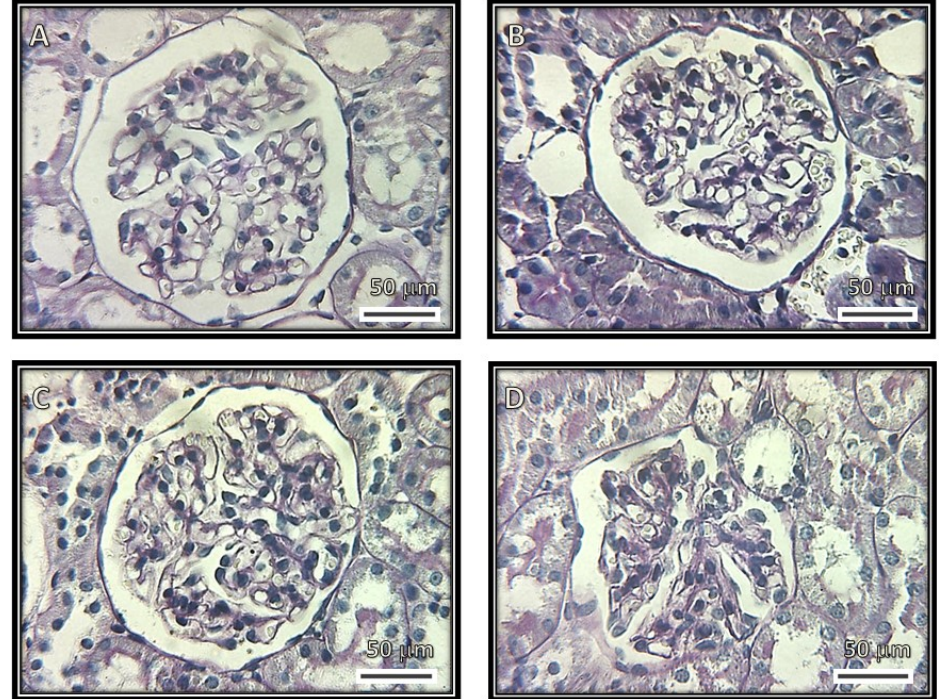
Figure 1. Representative photomicrographs of rat renal cortexes. The images show glomeruli from ( A ) control, ( B ) kidneys from rats injected with saline solution and ( C ) kidneys from rats injected with serum from healthy subjects. Open capillary loops, basement membranes and Bowman’s capsules positive for periodic acid–Schi ff stain (PAS) staining can be observed in these panels. ( D ) Kidneys from rats that were injected with serum from patients with collapsing glomerulopathy. Retraction of the glomerular tuft, podocyte hypertrophy and injury, increased urinary space and presence of some vacuoles in the urinary space can be observed. (Periodic acid–Schi ff stains, 400 ×